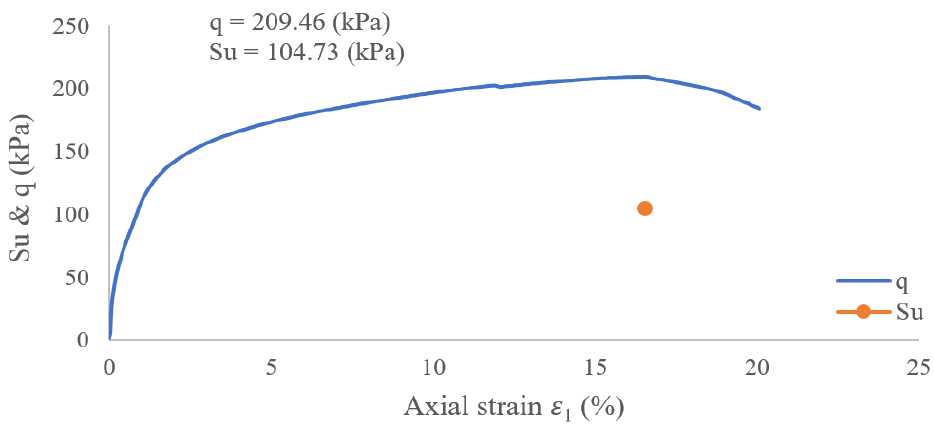
Figure 4. Stress–strain relationship in the monotonic triaxial test ( 𝒒 and 𝑺 𝒖 ) [33].